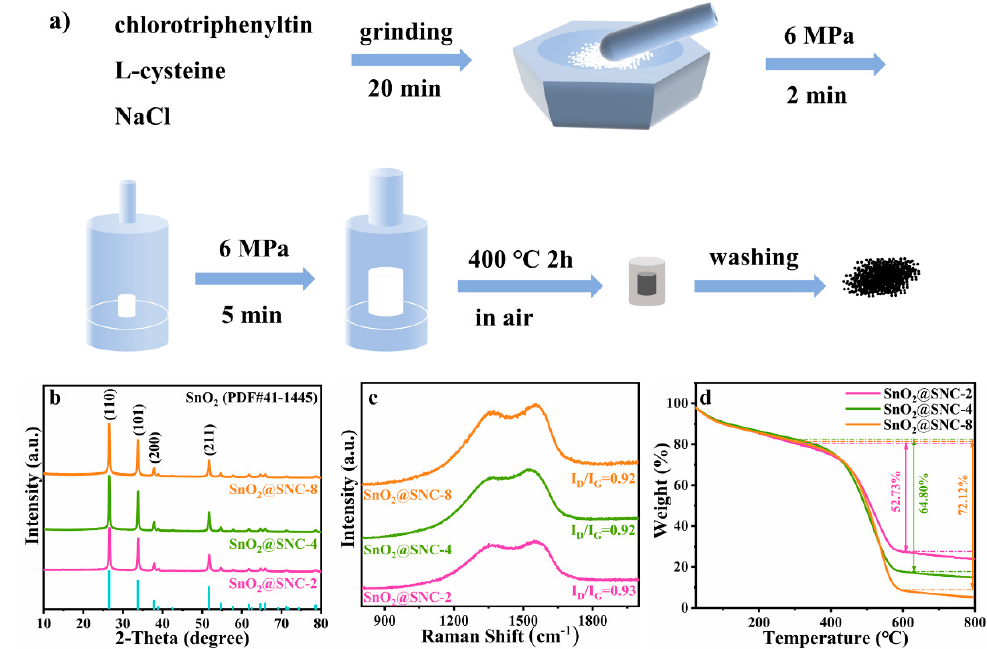
Figure 1. ( a ) Schematic illustration for the synthetic process of the SnO 2 @SNC composite materials. ( b ) XRD pattens, ( c ) Raman spectra and ( d ) TGA curves for the as-prepared SnO 2 @SNC − 2, SnO 2 @SNC − 4 and SnO 2 @SNC − 8 composite.